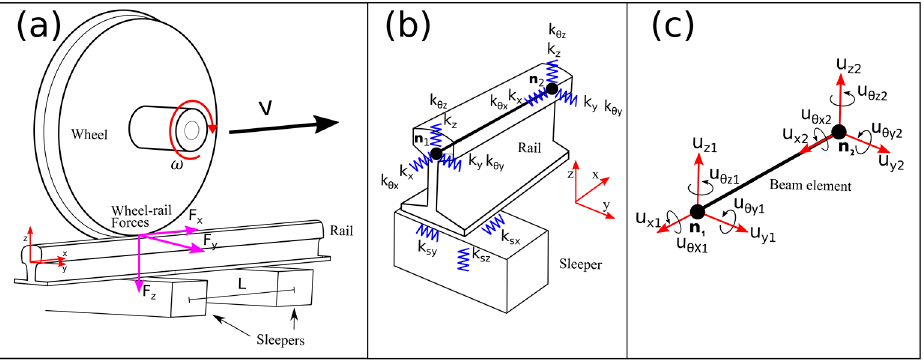
Figure 2. ( a ) an example of a wheel-rail interaction model; ( b ) the FEM model of the rail with stiff- ness; ( c ) a single 12-degree-of-freedom beam element. ( c ) a single 12-degree-of-freedom beam